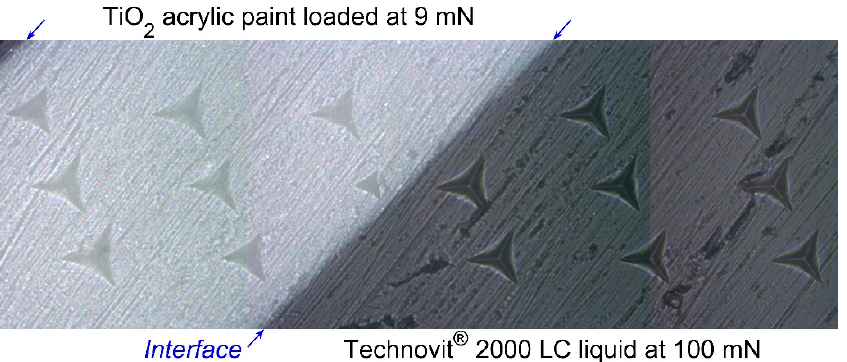
Figure 10. Optical microscope images of Berkovich imprints on the cross-sections of 0.26 mm-thick TiO 2 acrylic paint film (white region) and surrounding Technovit ® 2000 LC liquid as the embedding material (dark region), loaded at 9 and 100 mN, respectively.